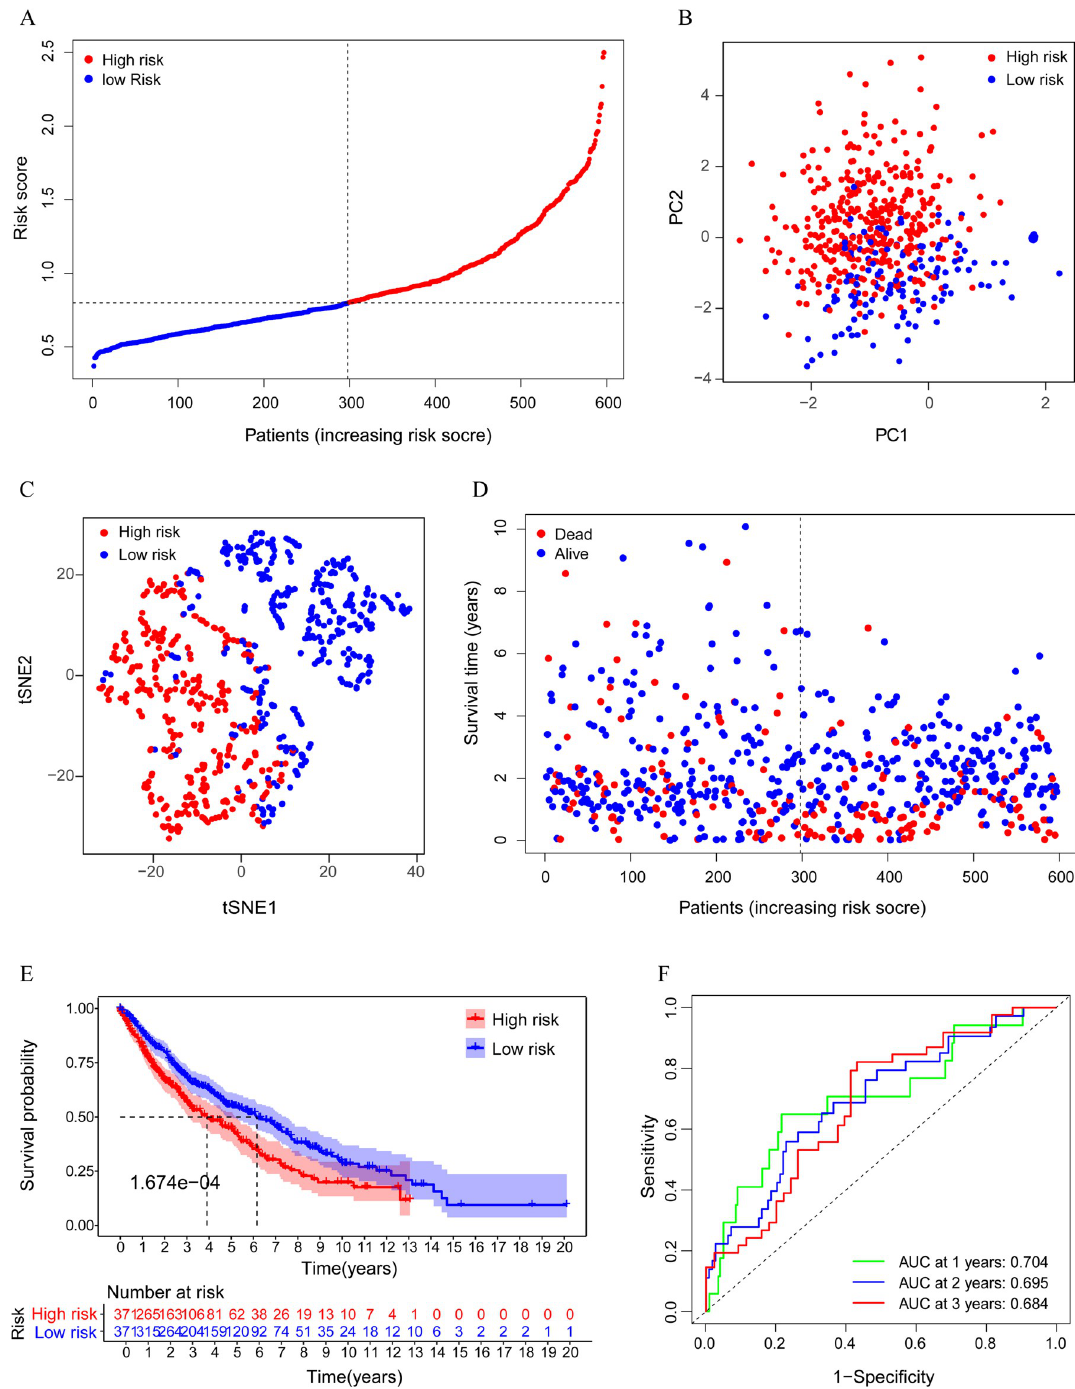
Fig 5. Prognostic analysis of the 5-gene signature model in the GEO cohort. A. The distribution by median value of the risk scores with this model. B. PCA plot. C. t-SNE analysis. D. The distributions of OS status, OS and risk score. E. Kaplan-Meier curves for the OS of patients in the high-risk group and low-risk group. F. AUC of time-dependent ROC curves verified the prognostic performance of the risk score.